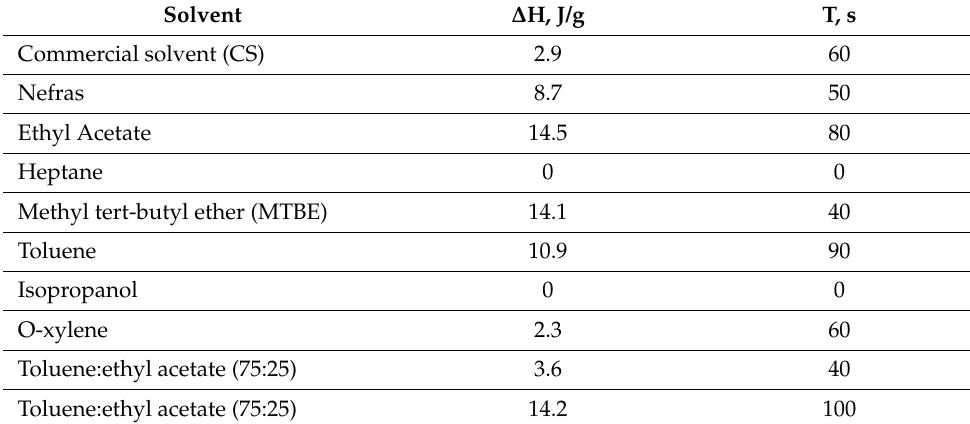
Table 3. Oil dissolution heat and time in various pure solvents and their